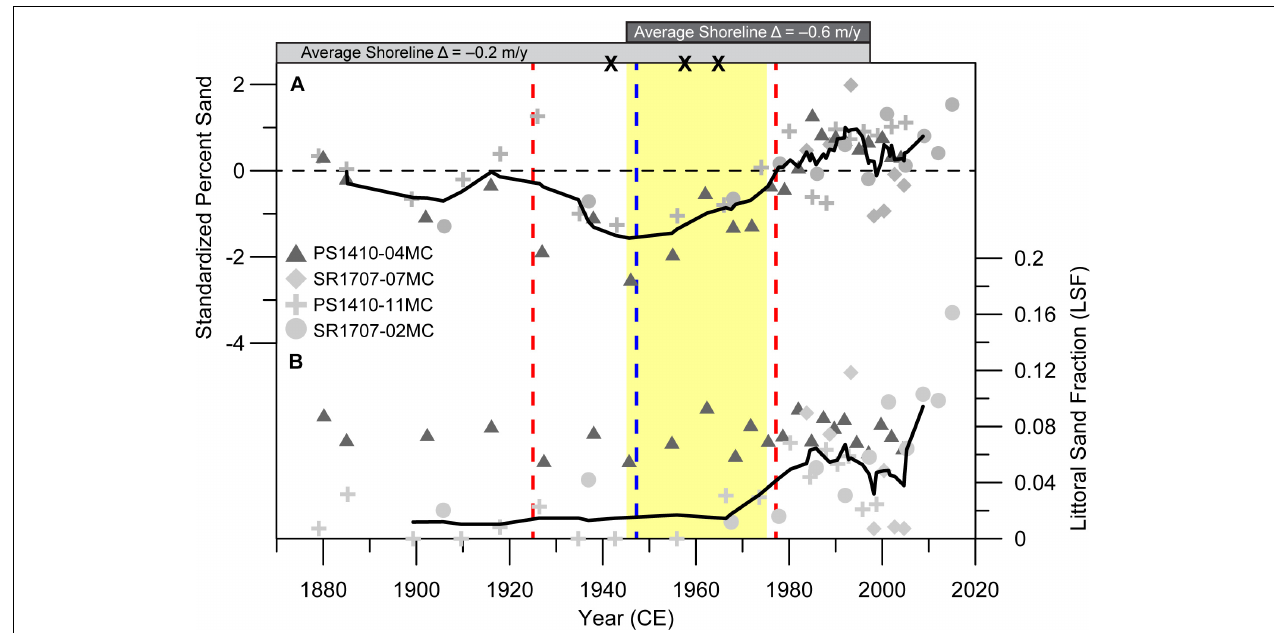
FIGURE 9 | Plot of grain size parameters versus time for the modern time period. (A) The standardized percent sand for all cores (see text for explanation) with a 5-point moving average (black line) computed from all core data combined. (B) The littoral sand fraction for all cores with a 5-point moving average (black line) that excludes PS1410-04MC (dark gray triangles). For both plots the transitions between major PDO shifts (Mantua et al., 1997) are shown by the vertical dashed lines, where a red line indicates a transition into a positive PDO phase, and a blue line is a transition into a negative PDO phase. The yellow vertical bar indicates the period of maximum dam construction in California (Willis and Griggs, 2003), and the black Xs at the top denote the implementation of the 3 largest dams on the Salinas River (Farnsworth and Milliman, 2003). The gray horizontal bars at the top of the plot show shoreline change results where the width of the bar approximates the period with which the data was averaged, and negative values indicate net erosion (Hapke et al.,